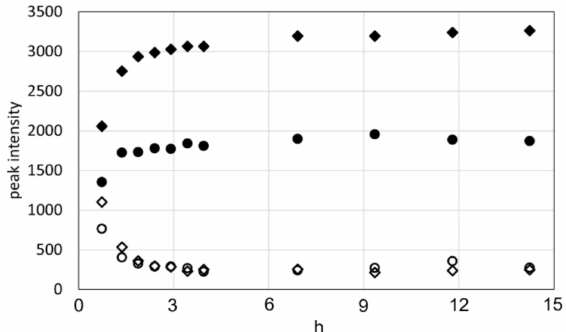
Figure 4. Peak intensity for the C α H and C β H 2 protons of unformylated and formylated Ser residues with time after the dissolution of RSSP(VLI) in formic acid. (● formylated Hα , ◆ formylated H β , 〇 unformylated H α , ◇ unformylated H β ).